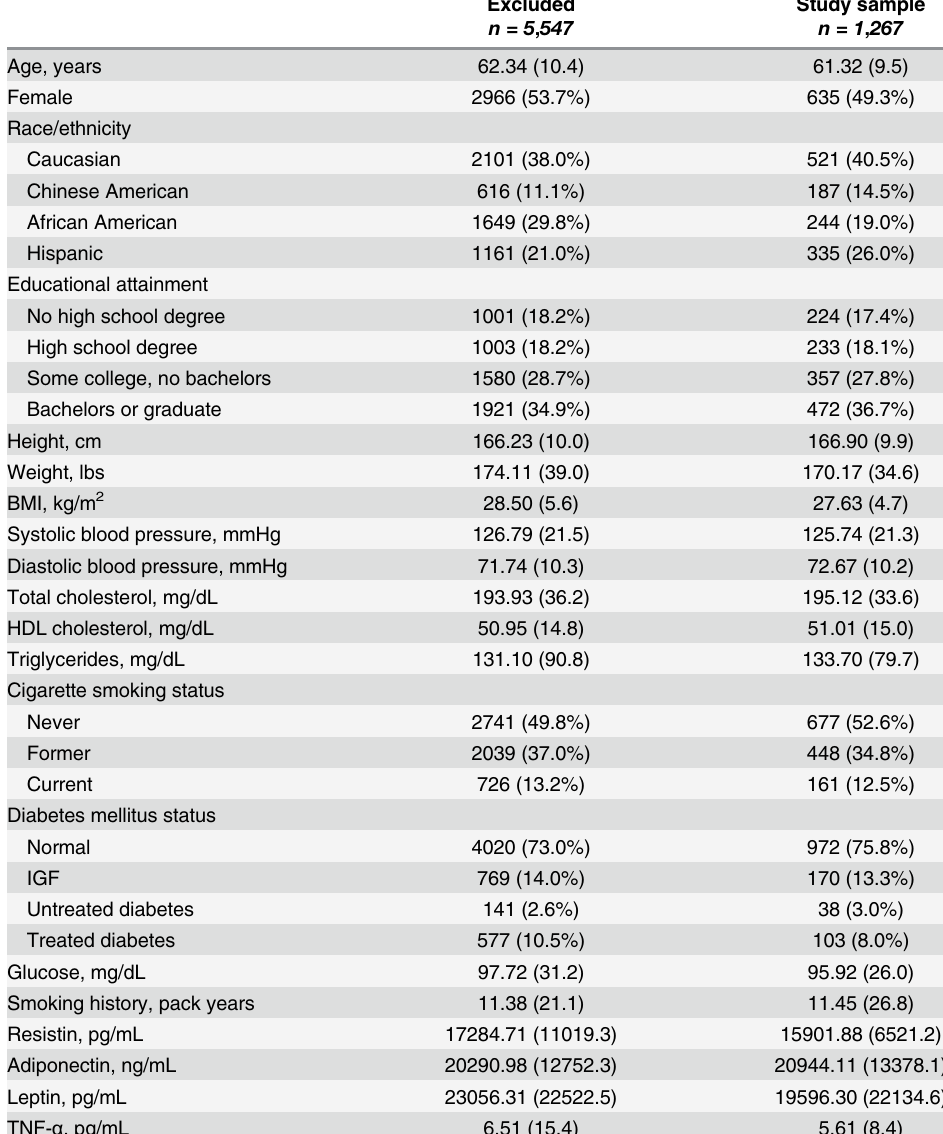
Table 1. Characteristics of the study sample. Participant characteristics are summarized as mean (SD) or n